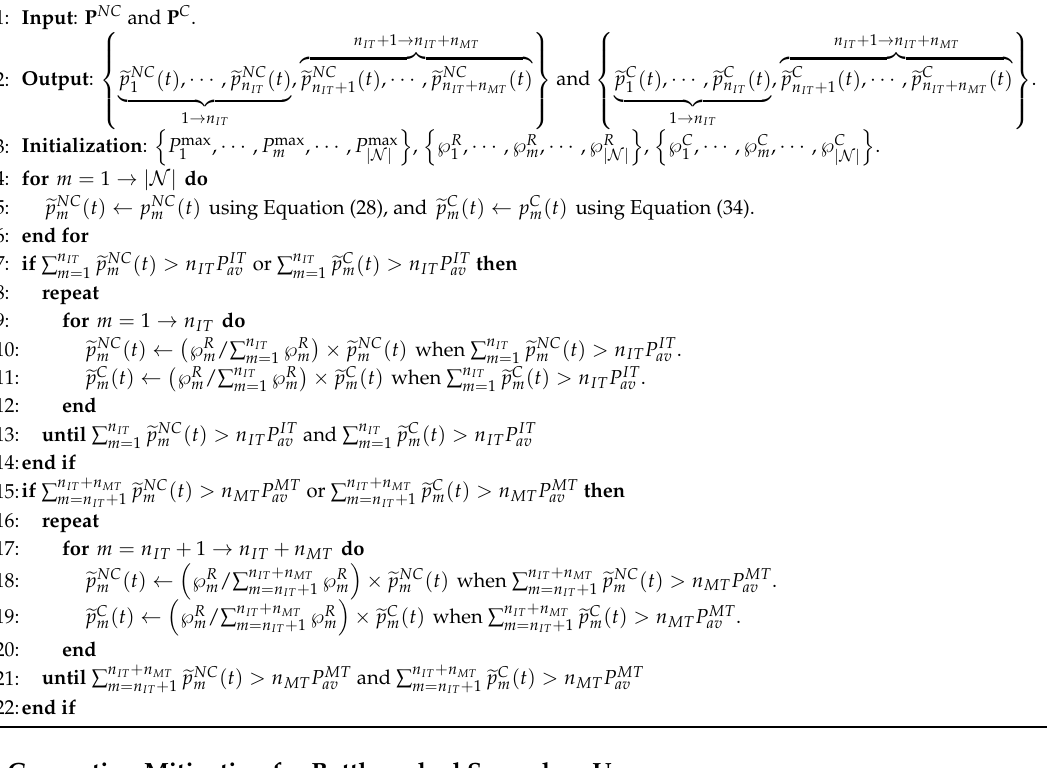
Algorithm 2 : Distributed Optimal Transmit Power Adjust